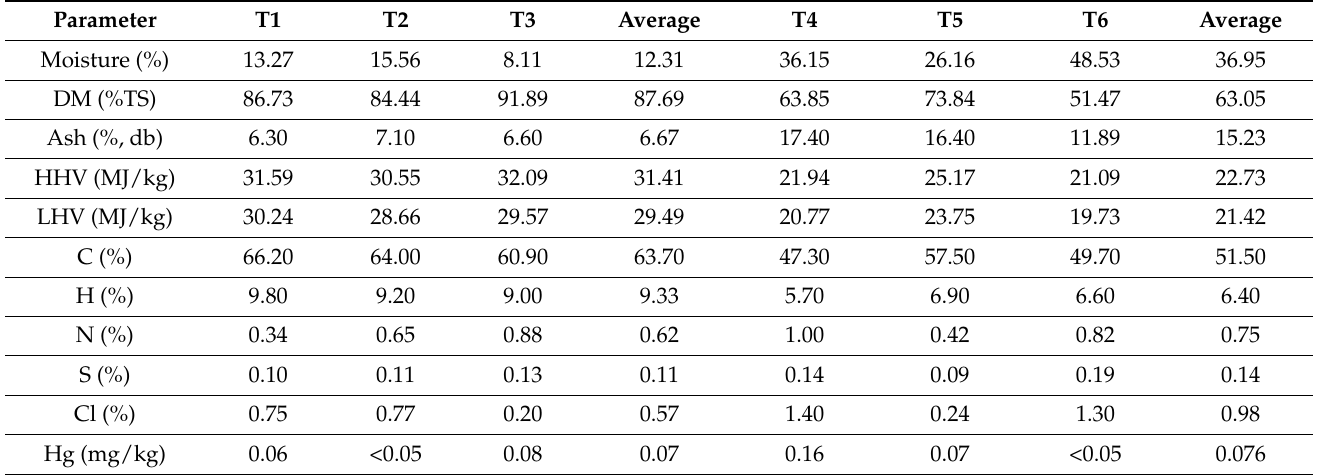
Table 1. Proximate, heating values and elemental analysis of RDF samples.